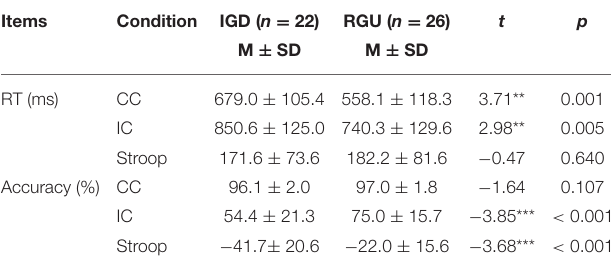
TABLE 3 | Differences between the IGD and RGU groups in the Stroop task. Items